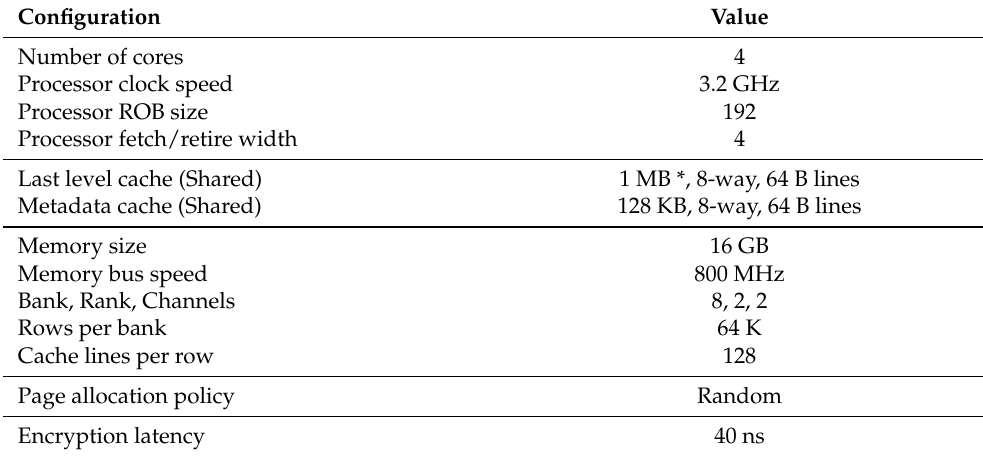
Table 4. Experimental system